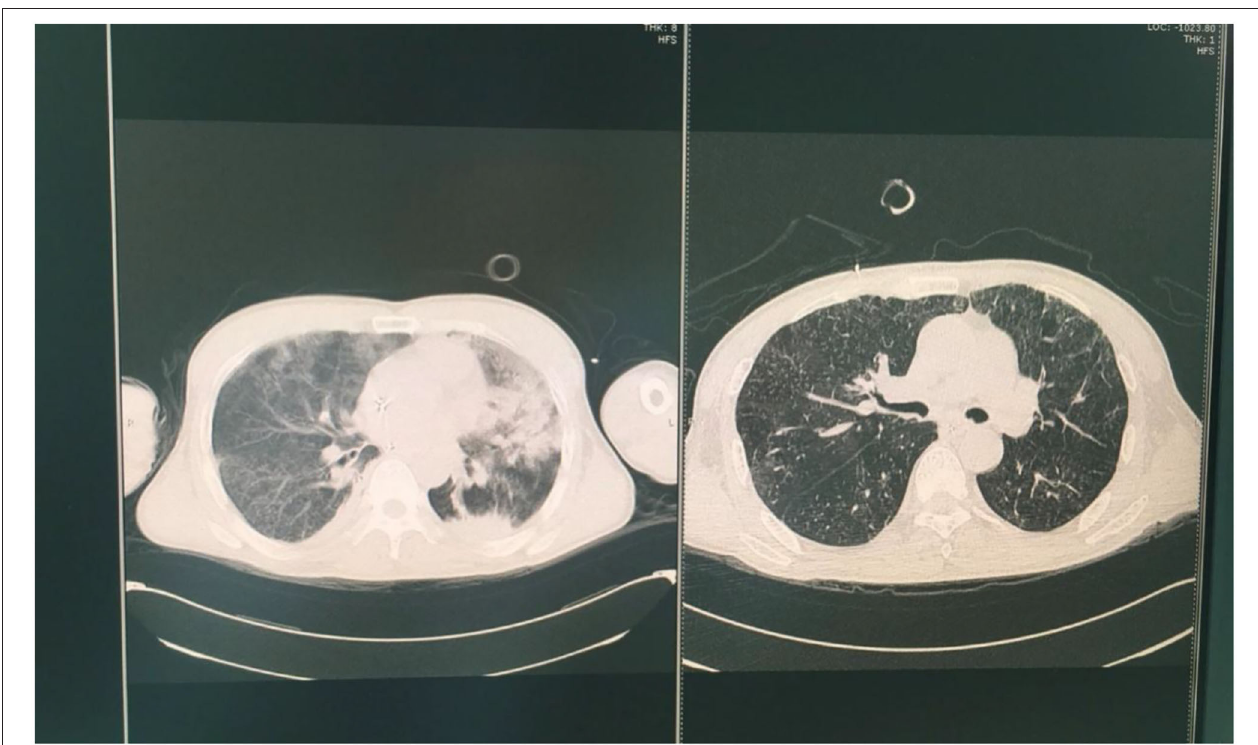
FIGURE 2 | The chest CT images on the second (left) and seventh day (right) after